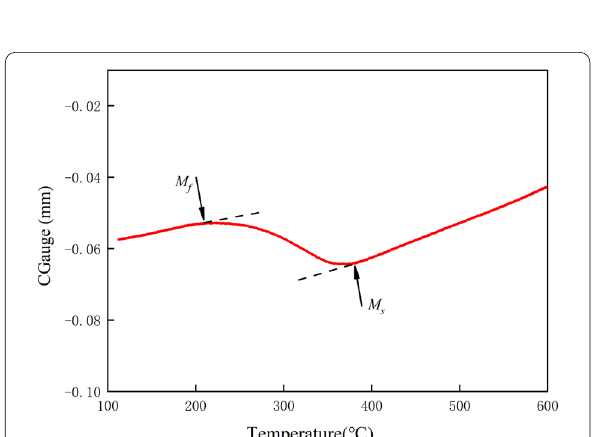
Figure 6 The third group of